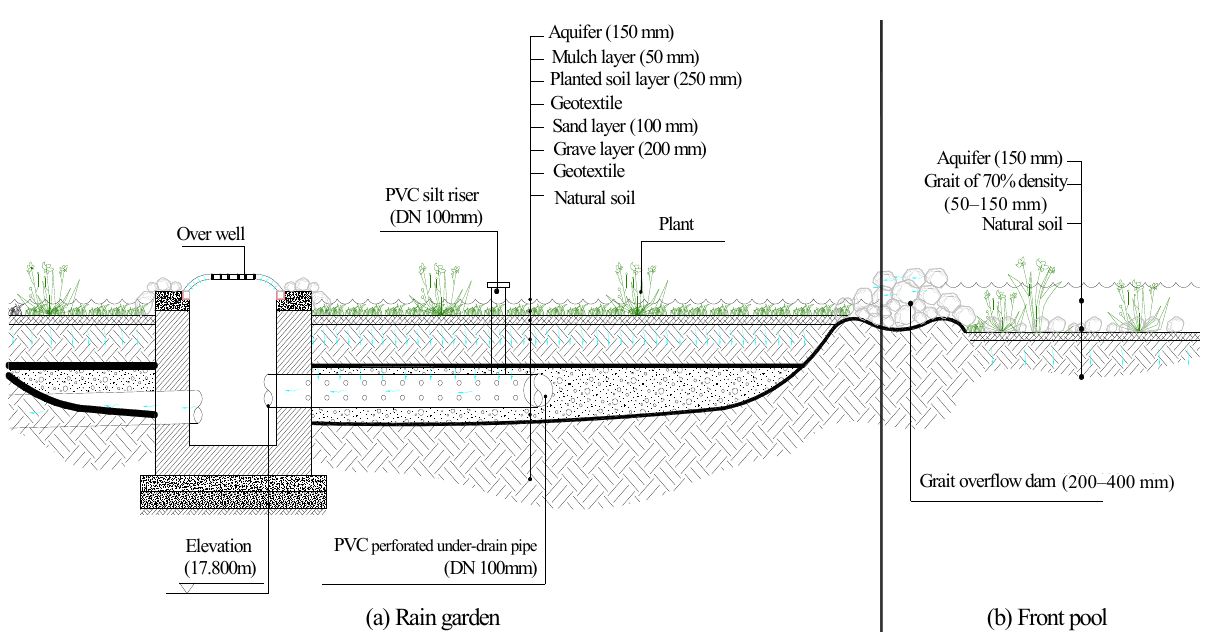
Figure 5. Section structure of the rain garden.